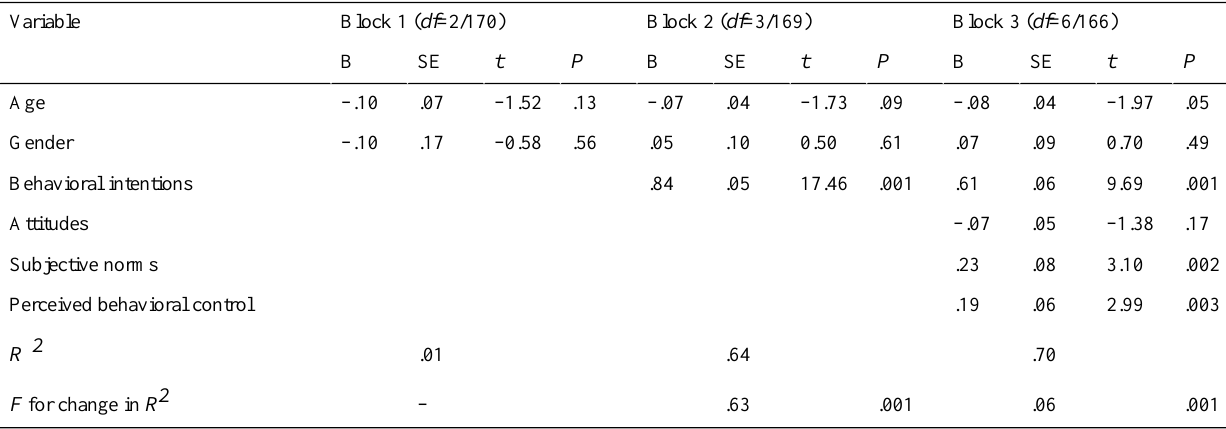
Table 5. Predictors of social media use: contributions of each variable block to changes in R2 (N=173).